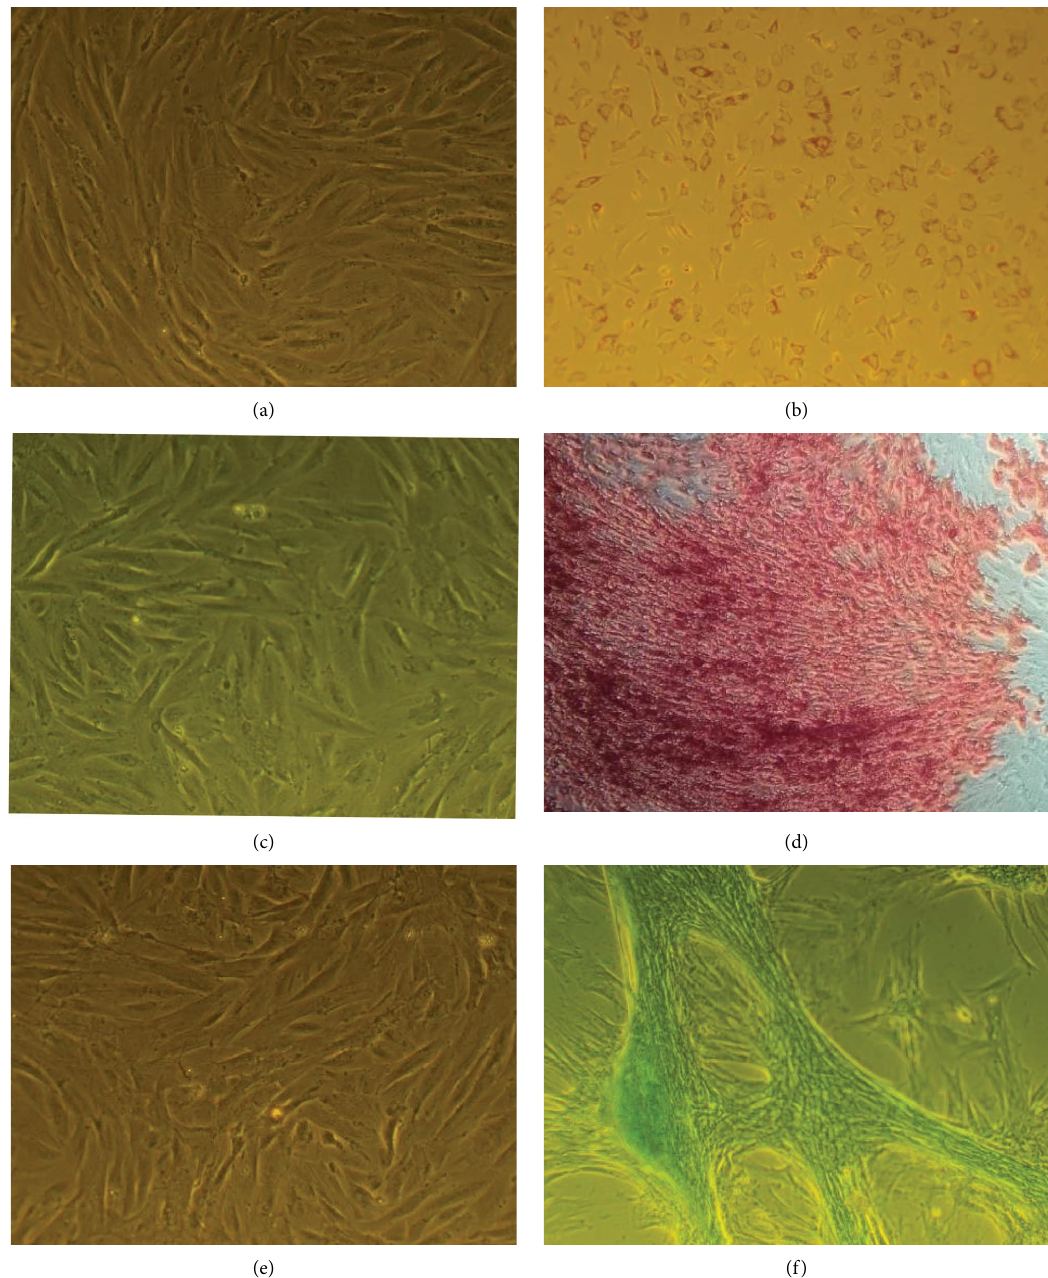
Figure 2: Representative microscopic images from induced three-layer diferentiation of SCAPs. Induced adipogenic diferentiation: control (a) and staining with Oil Red (b). Induced osteogenic diferentiation: control (c) and staining with Alizarin Red (d). Induced chondrogenic diferentiation: control (e) and staining with Alcian blue